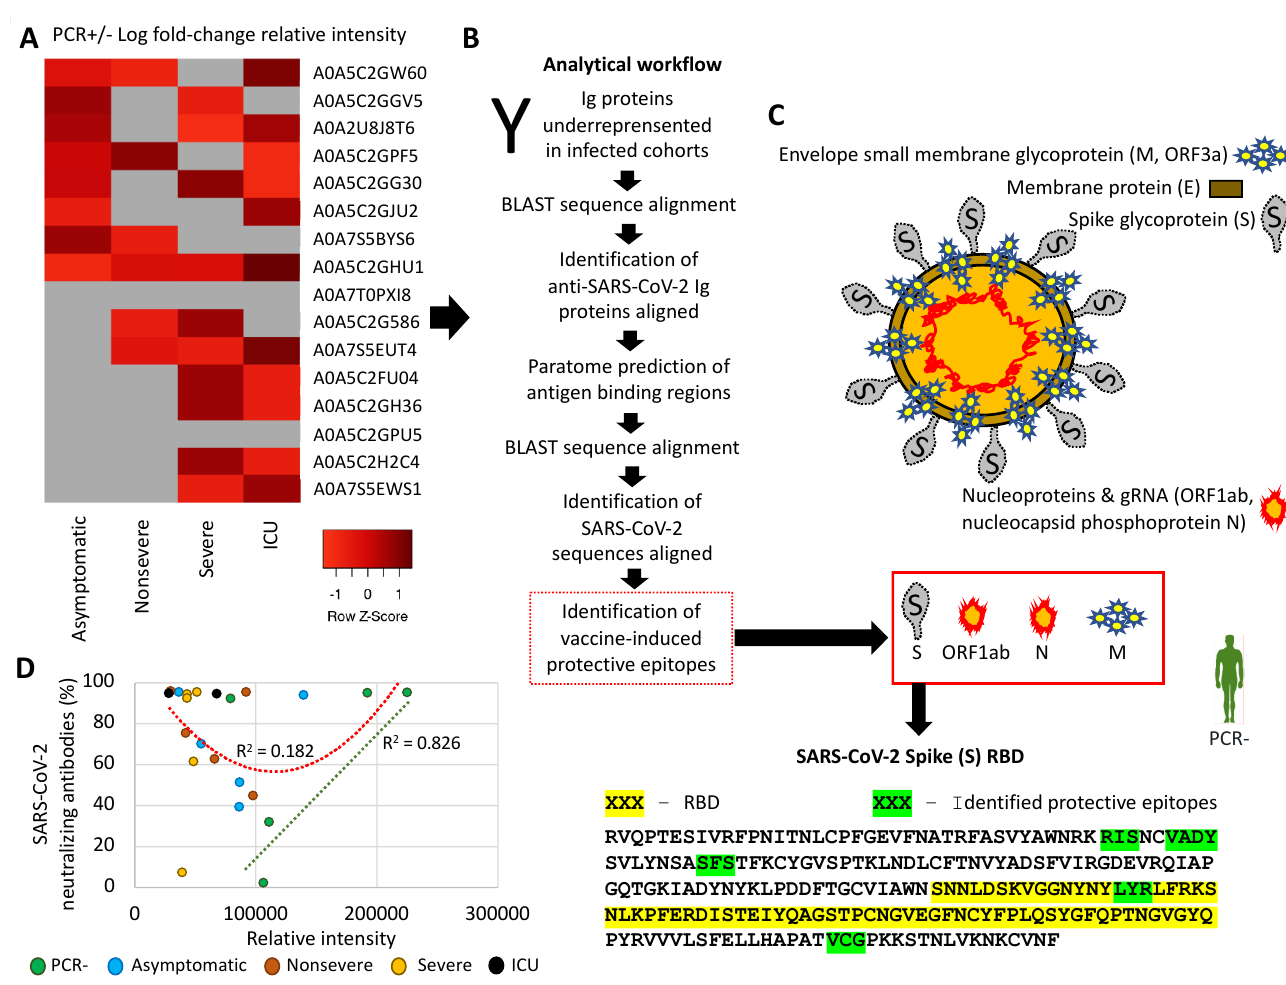
Figure 5. Serum-protein profiles of Ig underrepresented in vaccinated infected cohorts and identification of vaccine-induced protective epitopes. ( A ) Heatmap of PCR+/ − Log fold-change relative intensity (Z-scored original value) for Ig proteins underrepresented in infected cohorts. ( B ) Analytical workflow developed for the dentification of vaccine-induced protective epitopes. ( C ) Identification of SARS-CoV-2 proteins with predicted reactive epitopes to Ig underrepresented in infected cohorts and thus overrepresented in PCR – individuals. All methods and results are disclosed in Supplementary Materials Data File S2. ( D ) Correlation analysis between SARS-CoV-2-neutralizing antibodies (Table 1) and mass-spectra relative intensity of identified Igs with vaccine-induced protective epitopes (Supplementary Materials Data Files S1 and S2).